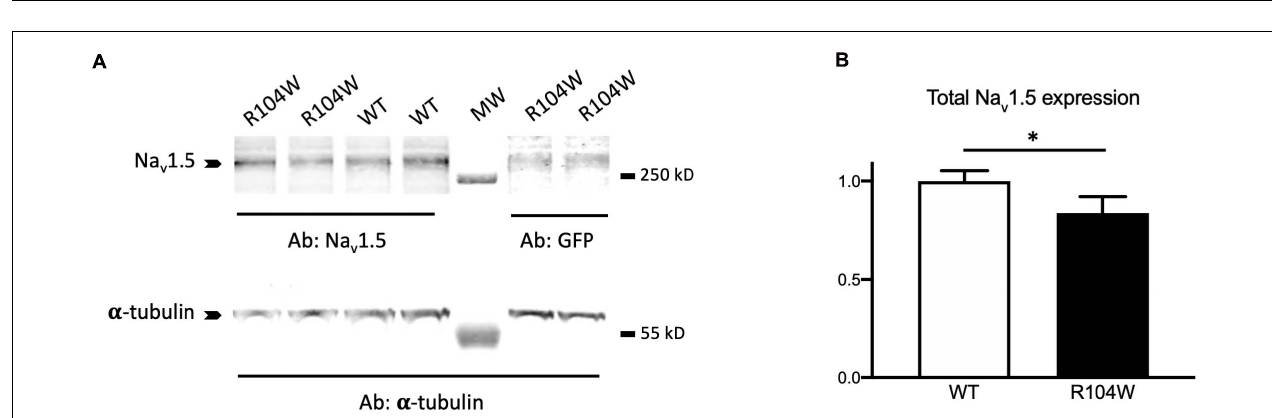
FIGURE 5 | hNa v 1.5-R104W overexpression decreased the Na v 1.5-protein total quantity. (A) Representative western blot of total cardiac proteins extracted from GFP (WT) or R104W injected mice. Total Na v 1.5 proteins were revealed using the anti-Na v 1.5 antibody and normalized to α -tubulin levels in hearts expressing GFP as a control of AAV injection and expression. (B) Total Na v 1.5 protein expression was significantly decreased in R104W injected mice ( n = 12), when compared to control ones ( n = 10). *: P <